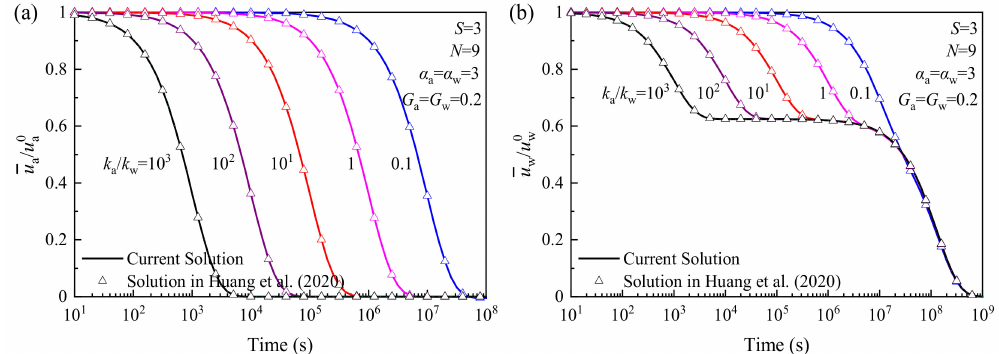
Figure 2. The comparison results of the current solutions versus existing solutions upon: ( a ) excess pore-air and ( b ) pore-water